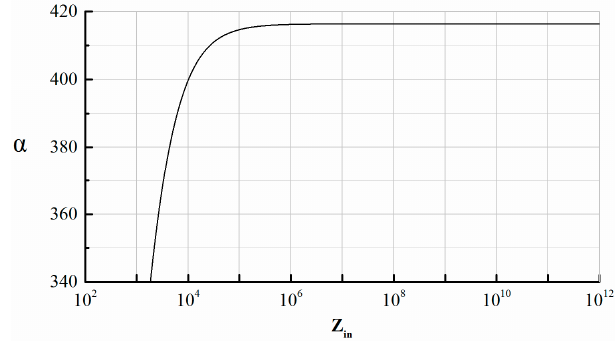
Figure 8. Relationship between α and Z in